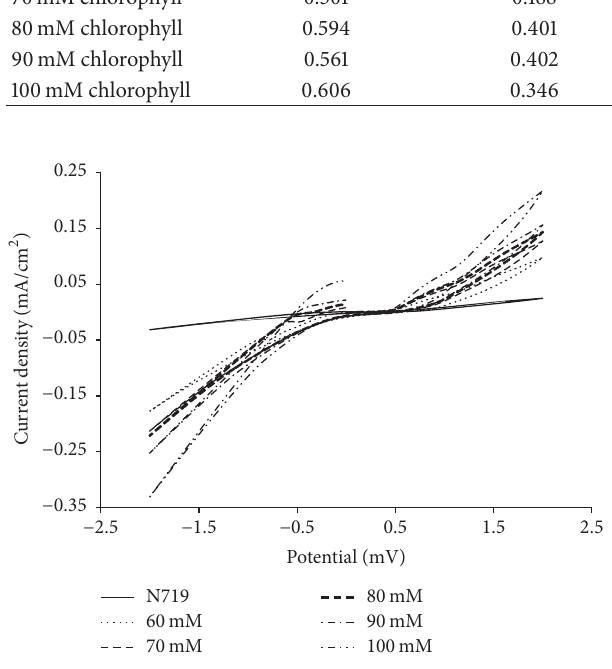
Figure 2: Cyclic voltammogram curves of N719 and chlorophyll dyes.